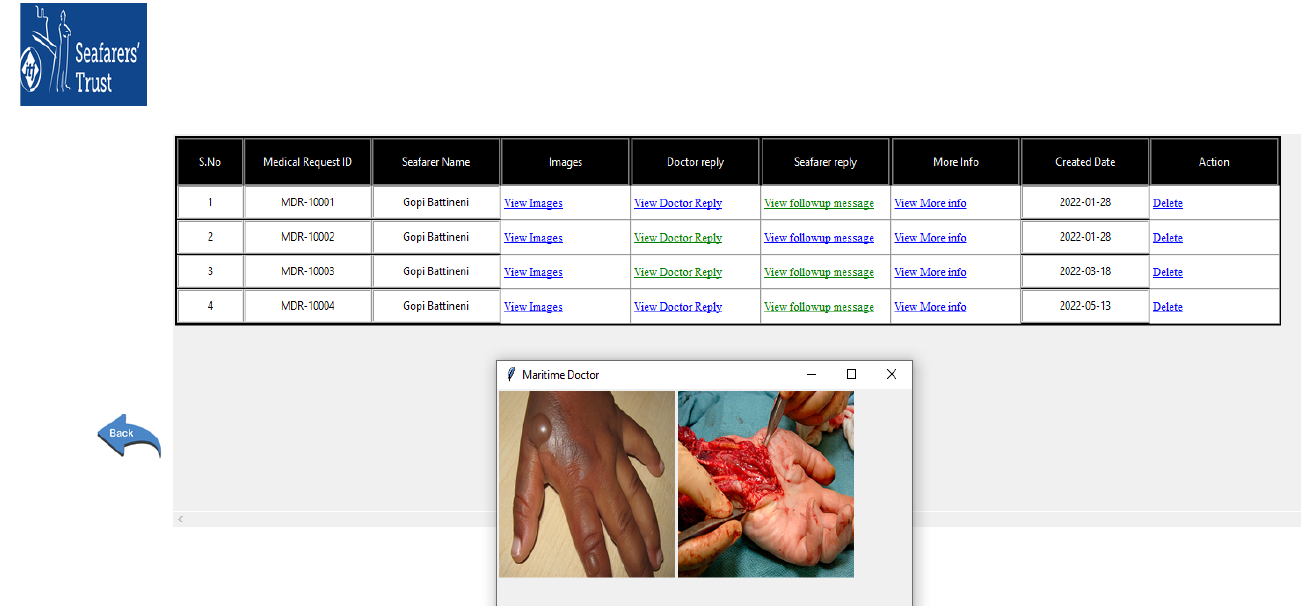
Figure 8. Onboard doctor response.